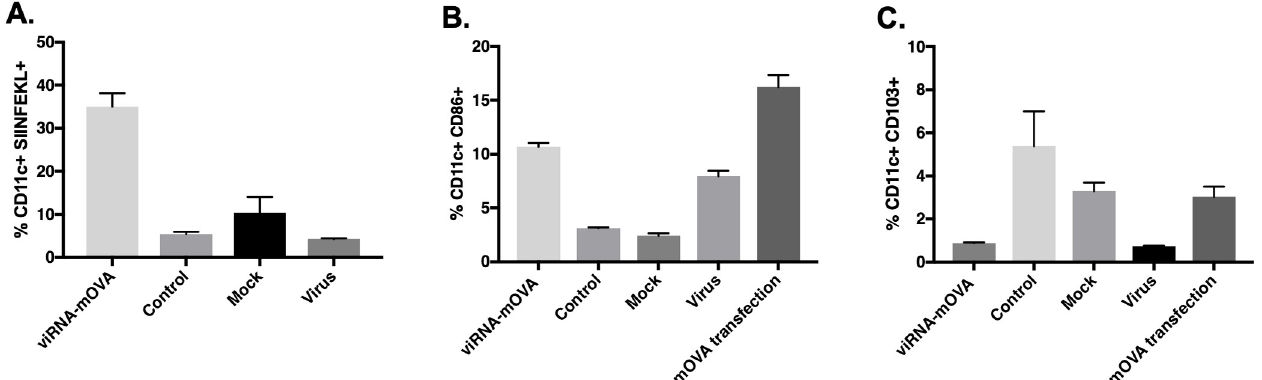
Fig 5. Antigen presentation and activation of bone marrow-derived dendritic cells after infection with viRNA-mOVA. Mouse bone marrow-derived dendritic cells were infected with sucrose purified viRNA-mOVA WR, sucrose purified mOVA complexed with cationic liposomes as a control, virus alone or non-treated cells as a mock. A) Antigen presentation was determined by flow cytometry using APC-conjugated anti-H-2Kb bound to SIINFEKL. B) Dendritic cell activation and C) migration marker expression was determined by flow cytometry using antibodies against murine CD86 and murine CD103, respectively. Each bar is the mean ± SEM of technical